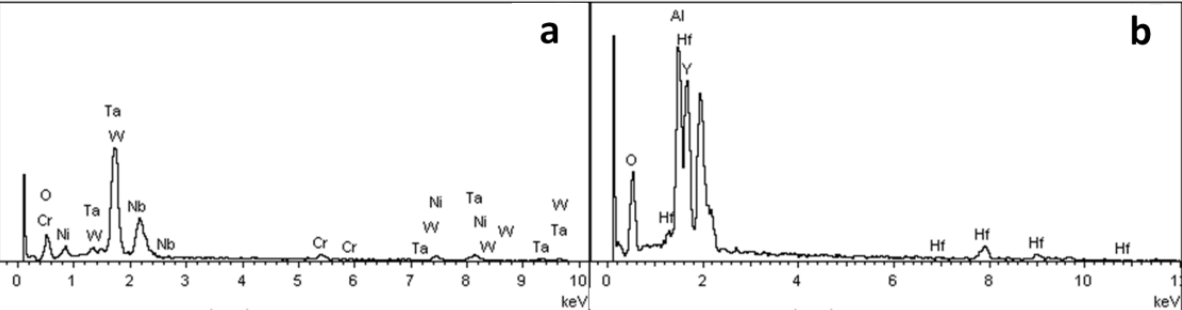
Figure 6. The EDS spectra: ( a ) point A in Figure 5b, and ( b ) point B in Figure 5c.